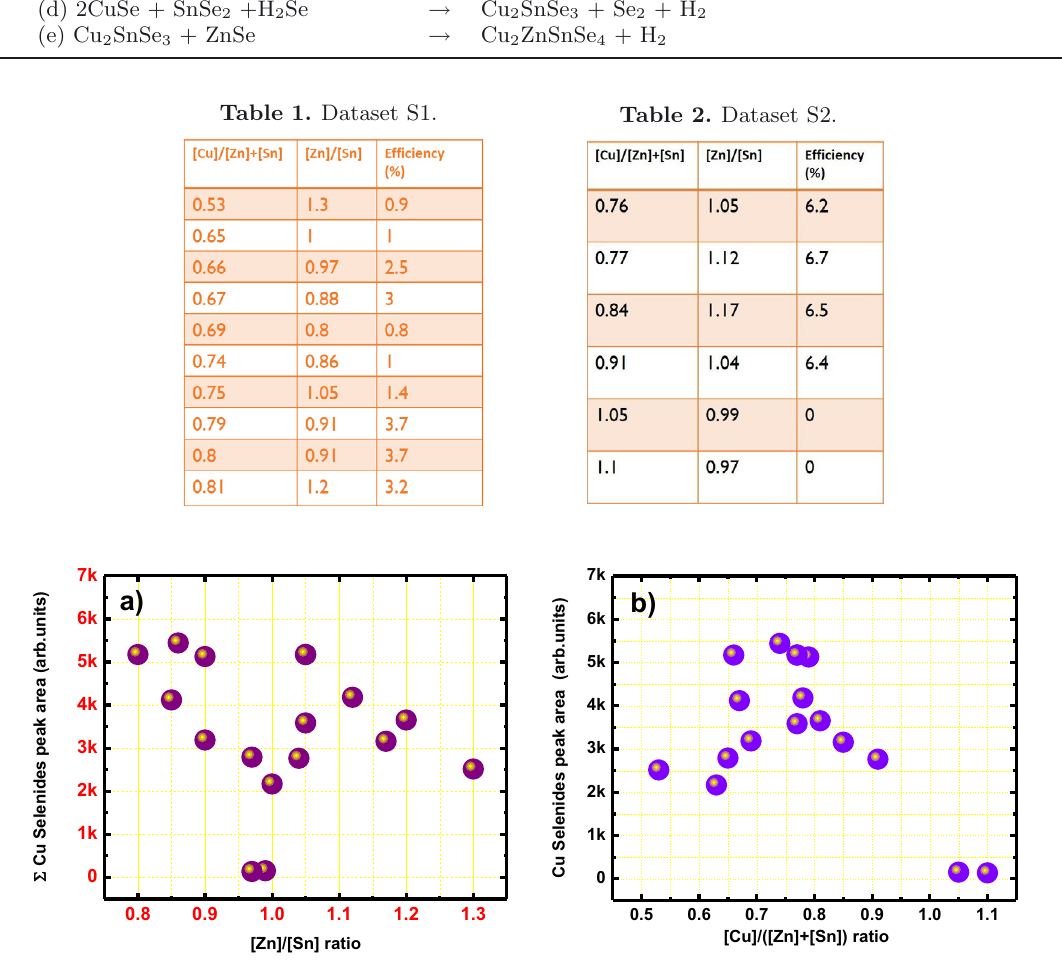
Fig. 1. Amount of Cu selenides (CuSe, Cu 2 − x Se and Cu x Se) in terms of area under the corresponding XRD peak as a function of (a) [Zn]/[Sn] and (b) [Cu]/([Zn] + [Sn]) ratios measured after selenization at 450 ◦